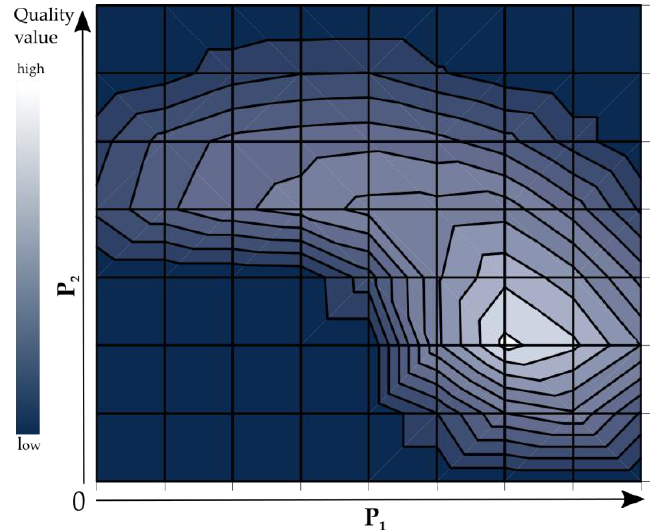
Figure 4. Example of surface chart of resulting quality values at different parameter combinations.